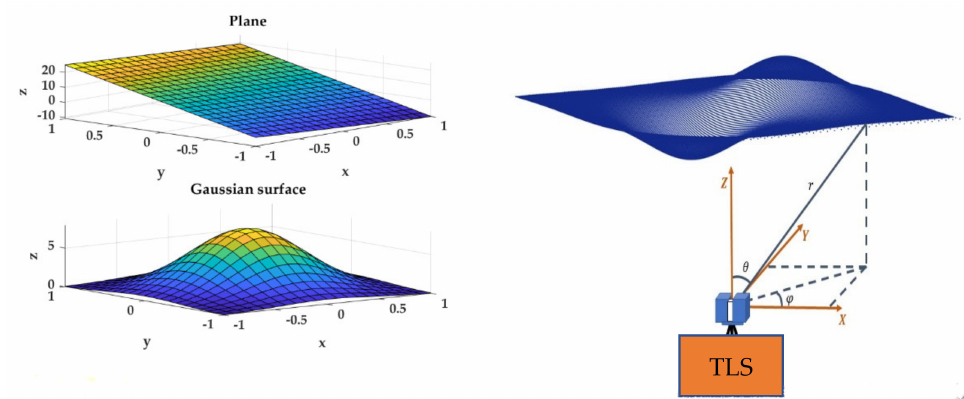
Figure 3. ( left,top ): Simulated plane. ( left,bottom ): Simulated Gaussian surface. ( right ): Origin of the laser scanner in Cartesian and polar coordinates. We call θ = VA , ϕ = HA .